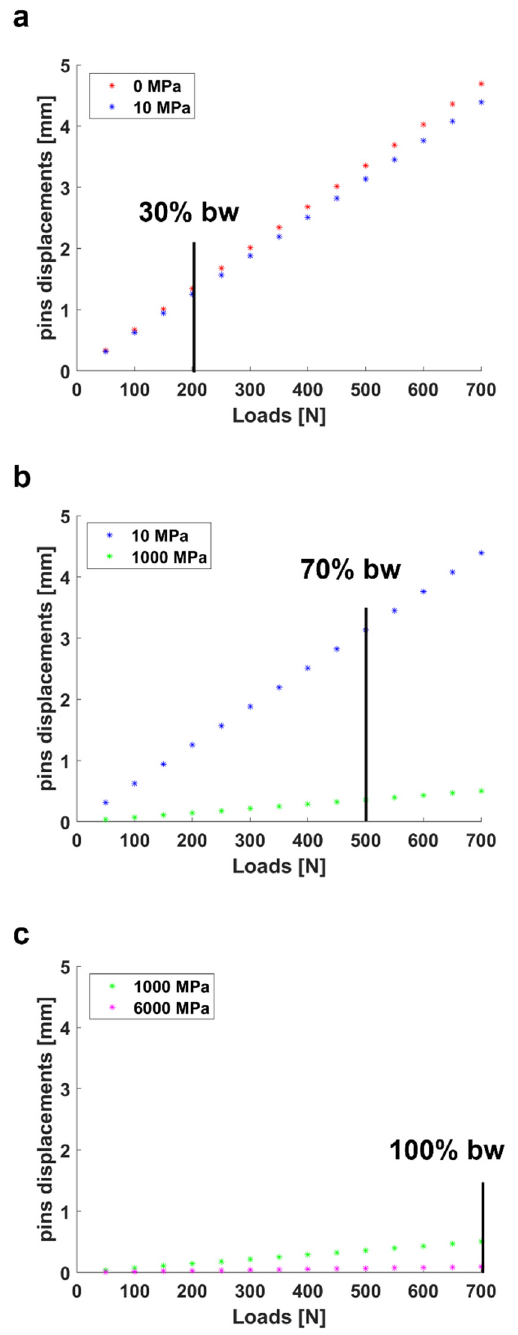
Figure 8. Pins displacements calculated in the simulation for: ( a ) inflammation/soft callus phase, ( b ) soft callus/hard callus phase and ( c ) remodelling phase. In the third phase, the patient is supposed to be able to stand on his full weight without any problem. Indeed, the estimated movement of the pins at this stage is very limited (Figure 8c). As expected, and represented in the graphs of Figure 8, the pins displacements increased with an increase in the applied load, while it decreased with increasing bone callus stiffness. The range of pins displacements was found to be 1.25–1.34 mm for the